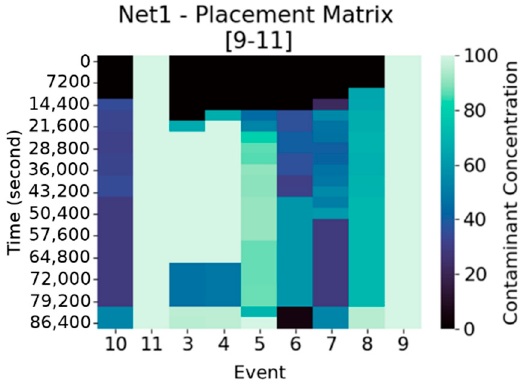
Figure 3. Sensor placement matrix for a sensor placement consisting of two sensors deployed at Locations 9 and 11.